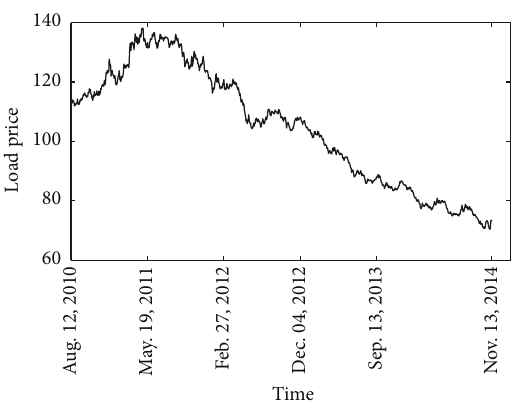
Figure 4: Load price series.